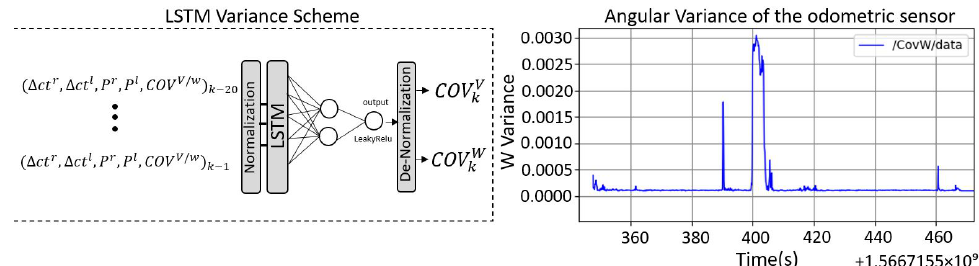
Figure 6. Scheme implemented to avoid non-systematic odometry errors, and the evolution of the angular velocity variance when a slippage happens in an example